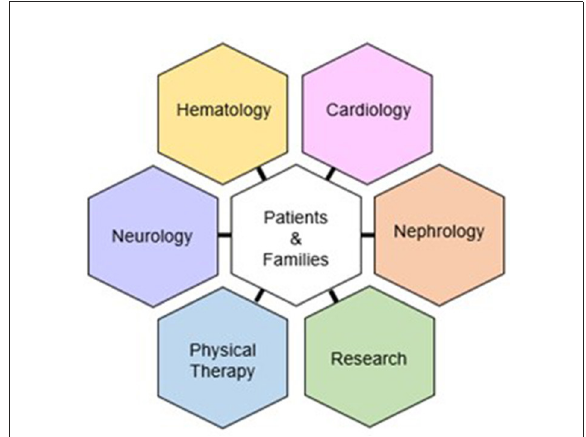
FIGURE2 Organizational structure of the Ohio State University Comprehensive Amyloidosis Clinic.